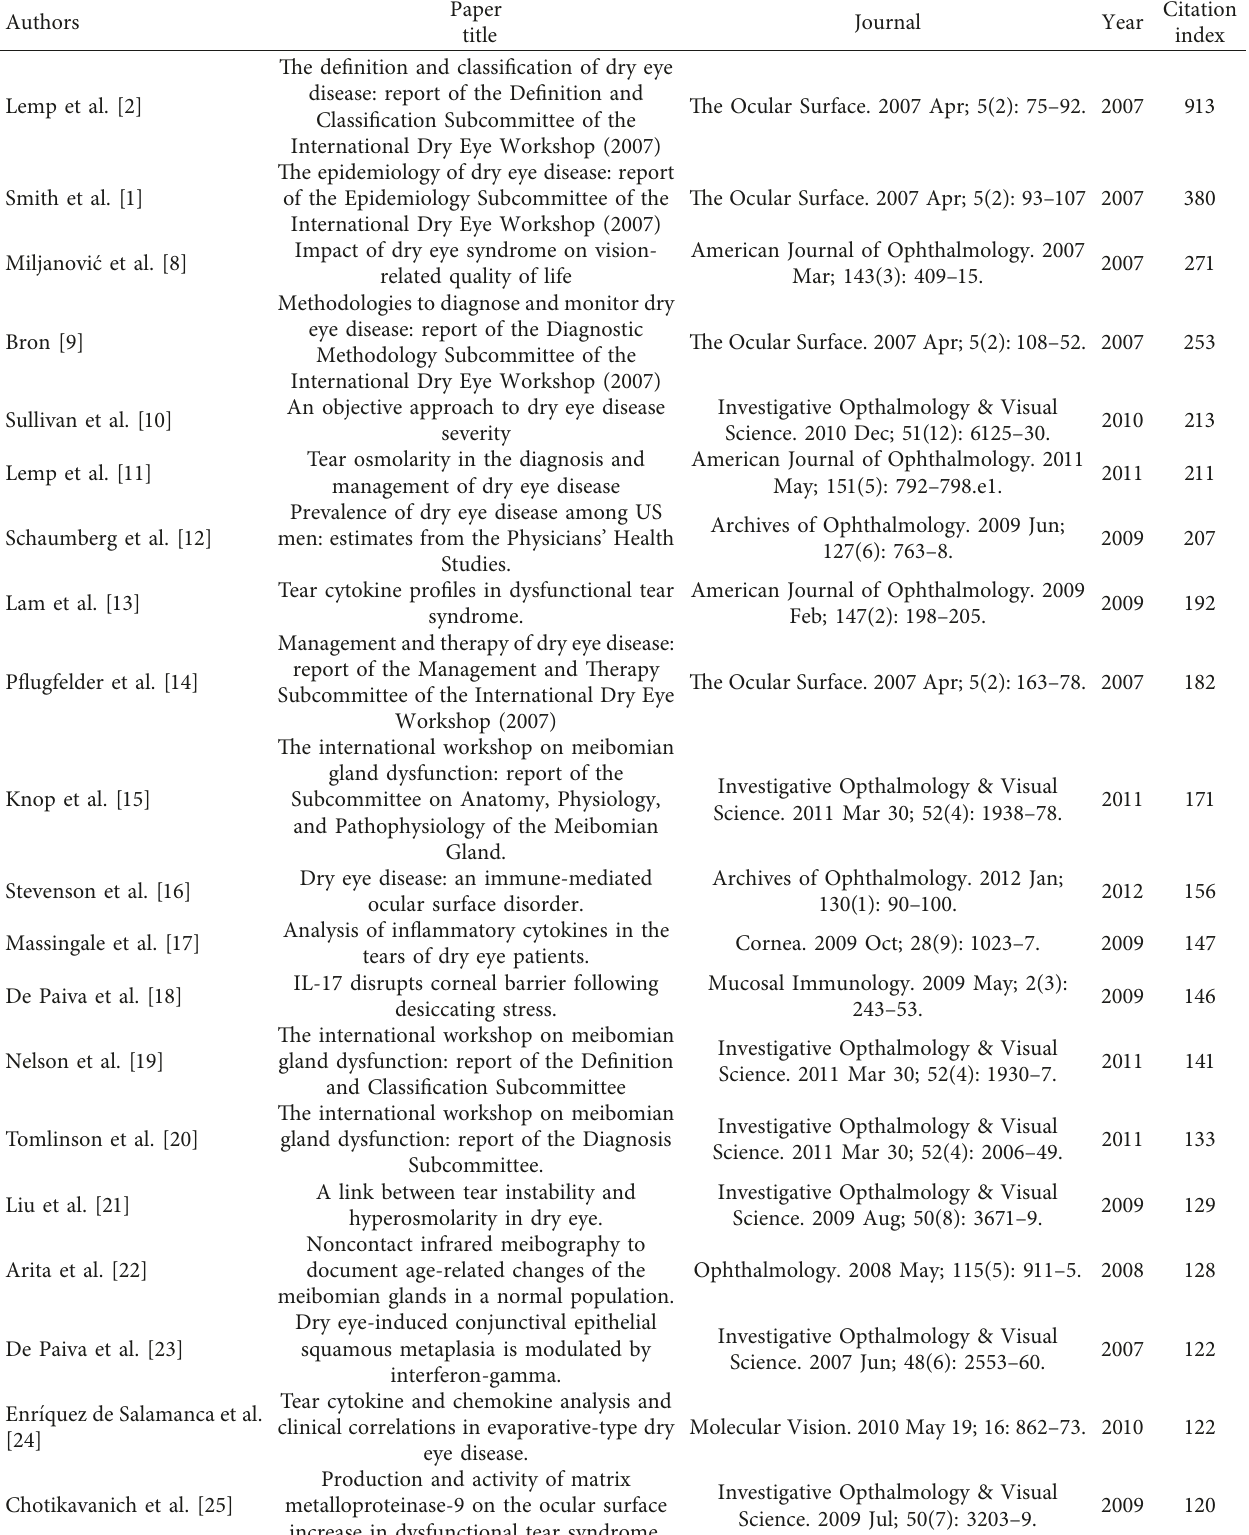
Table 1: 20 most cited papers from 2007 to 2018 in the dry eye citation